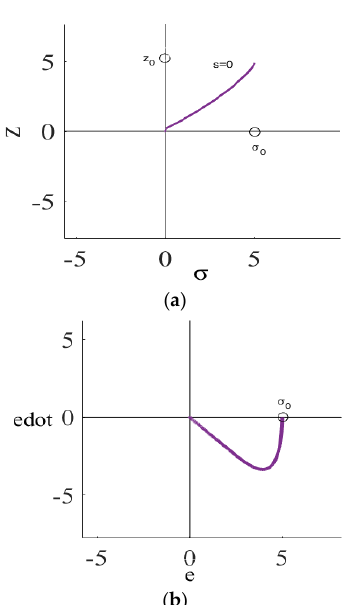
Figure 9. Sliding surface behavior in ISMC: ( a ) auxiliary sliding surface (s), ( b ) actual sliding surface ( 𝜎 ).